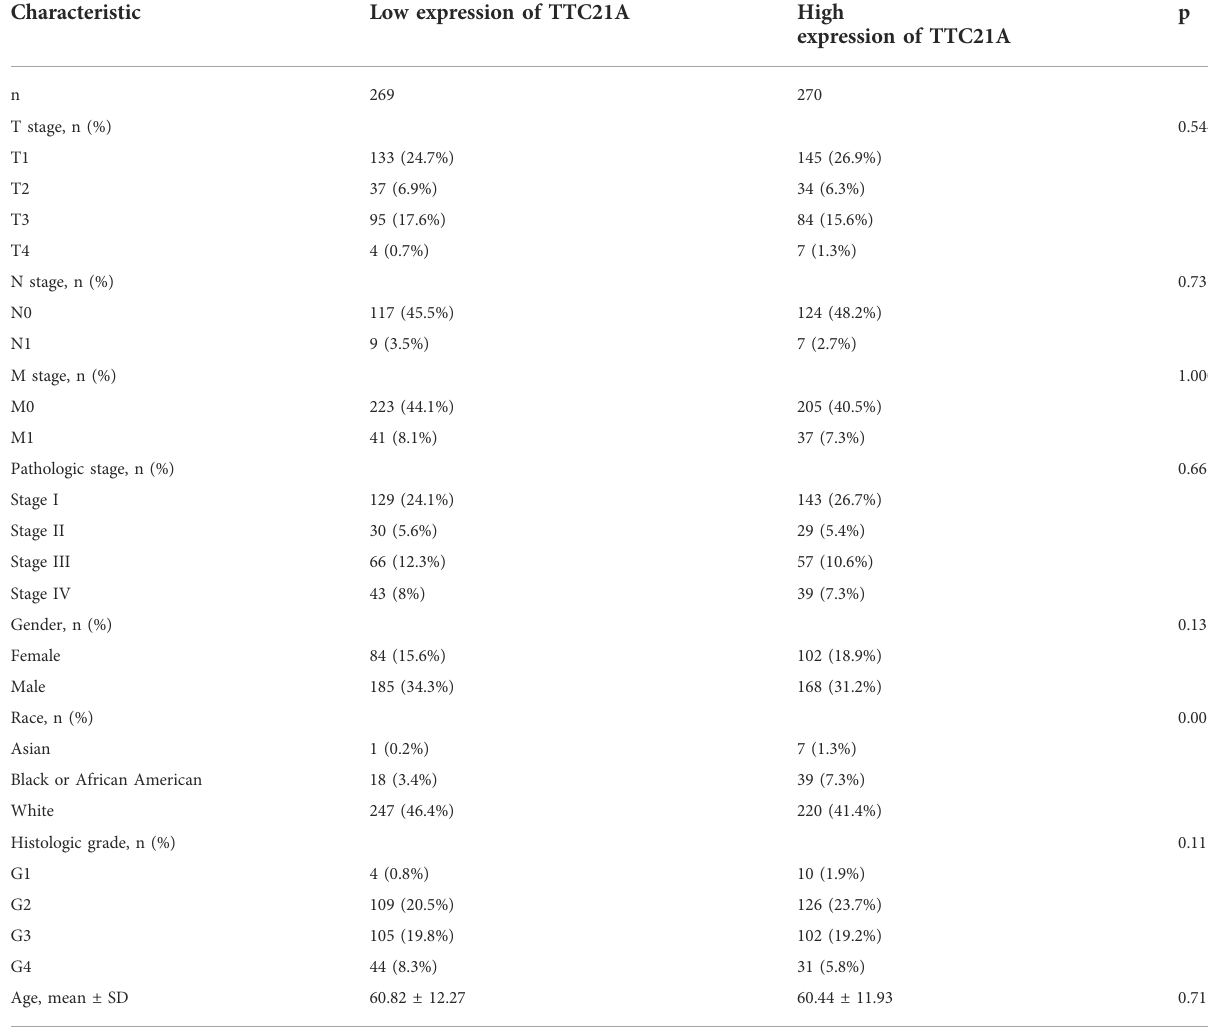
TABLE 1 clinicopathologic characteristics between high- and low-expression of TTC21A in ccRCC. Characteristic Low expression of TTC21A High